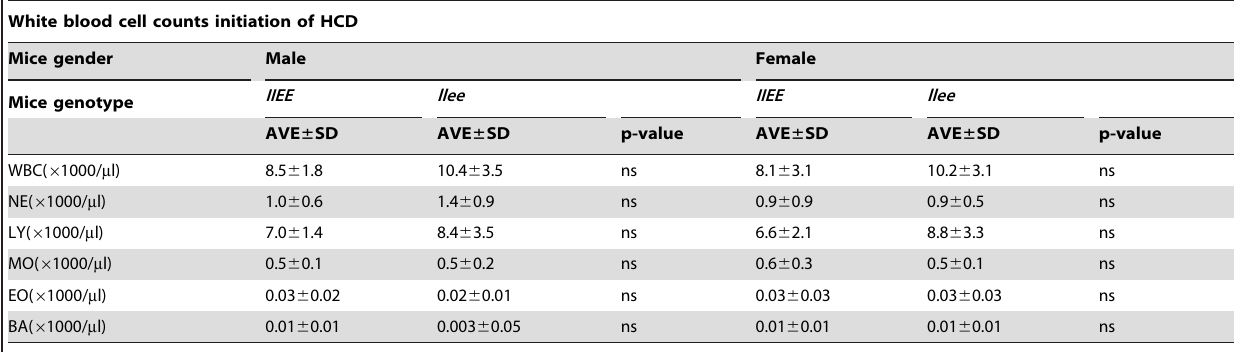
White blood cell counts initiation of